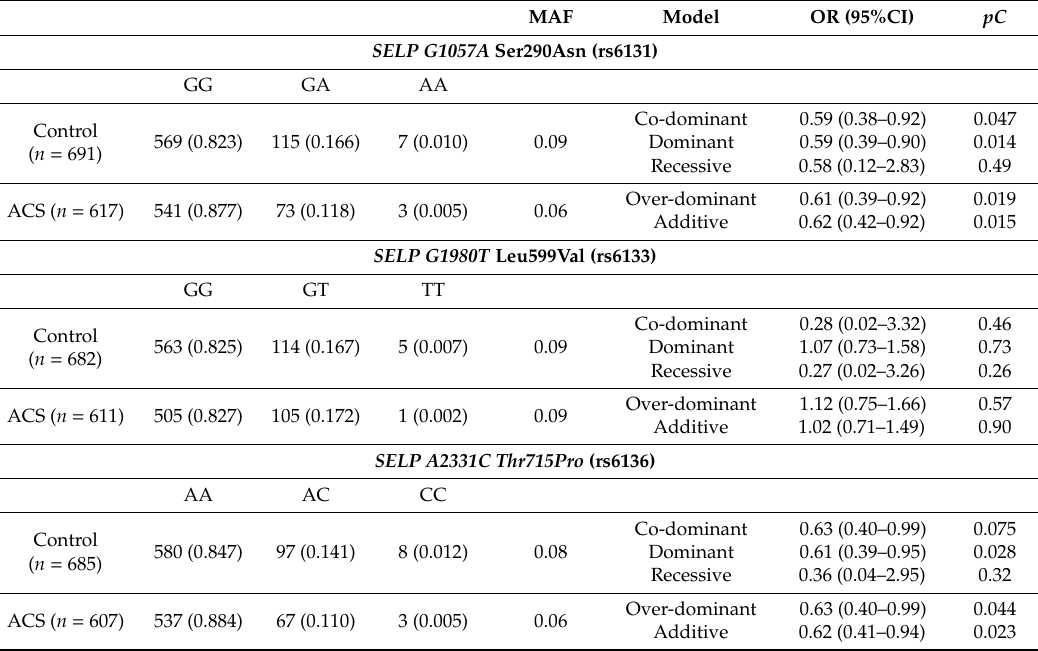
Table 2. Distribution of SEL-P polymorphisms in ACS patients and healthy